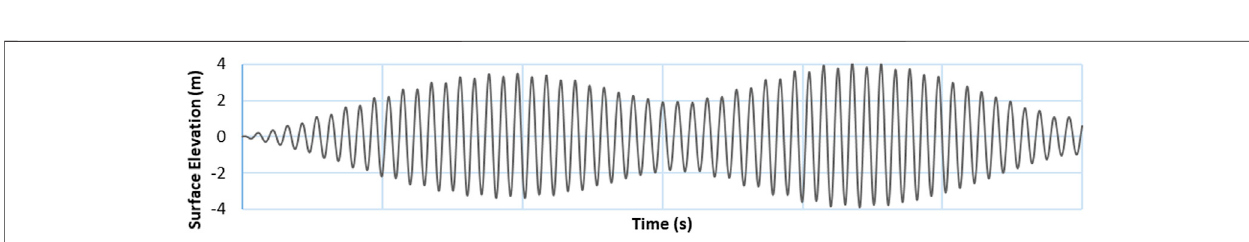
Frontiers in Energy Research |